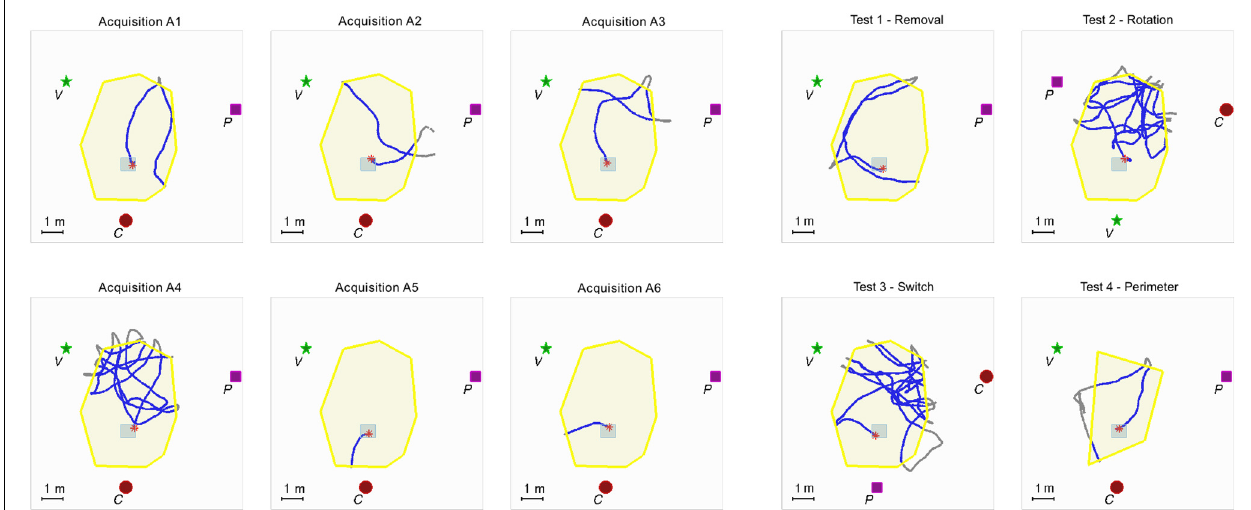
FIGURE 1 | Example of individual data for one participant. The experimental setup is composed of 3 auditory landmarks (red spot, green star and purple square, respectively labeled C for cicada, V for voice, and P for piano) surrounding the exploration zone (area = 22m 2 ) delineated by the yellow auditory border (wind heard when outside);